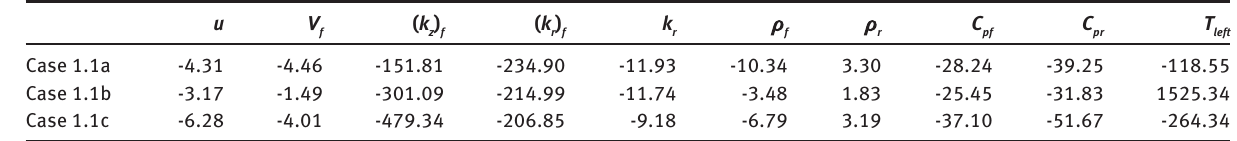
Table 4 Standard deviations of the correlation coefficients between the RIPs and the random output parameter (CDOCE) for 10 runs based on each MCS options of case